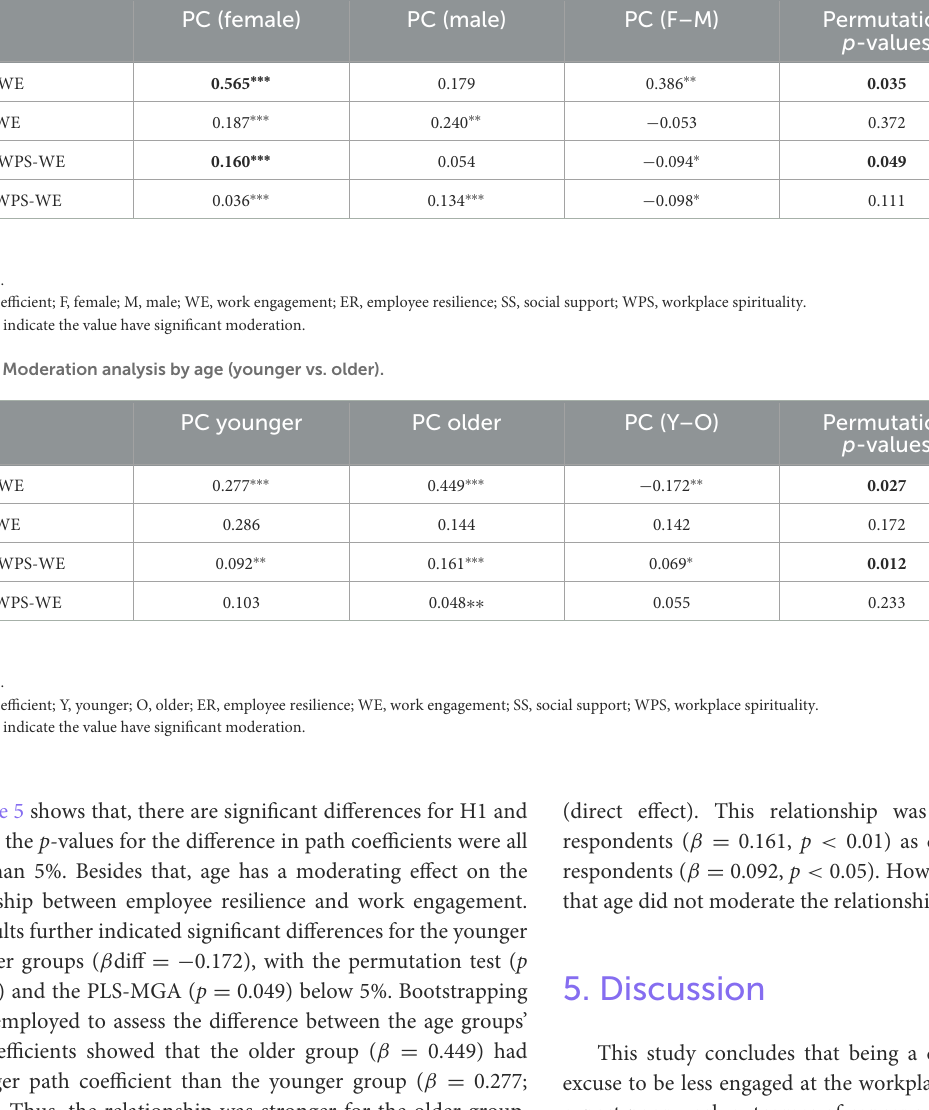
TABLE 4 Moderation analysis for gender (female vs. male). Path